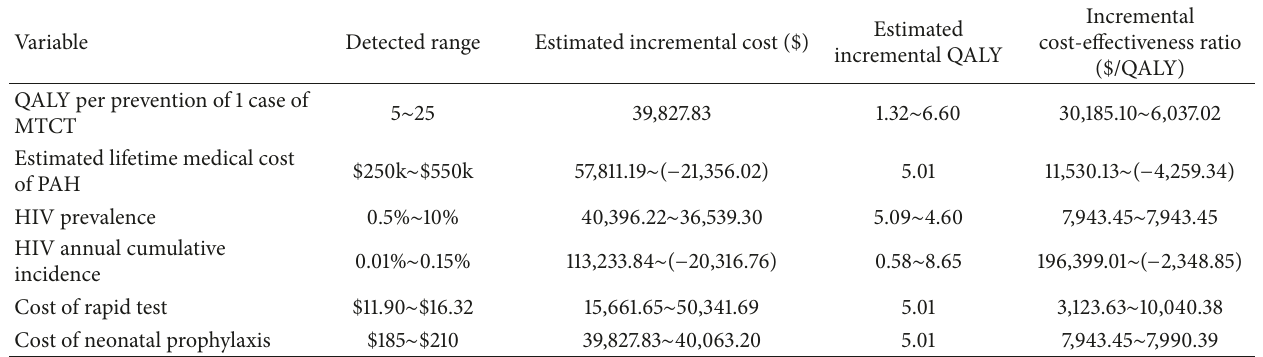
Table 5: Univariate sensitivity analysis of universal rapid HIV screening relative to standard of care I.